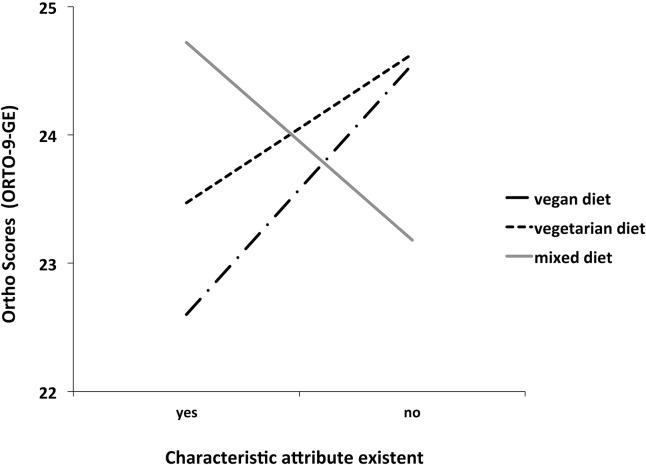
ORTO-9-GE scores associated with dieting style.ORTO-9-GE scores as a function of dieting style. Participants dieting style defined as either vegan, vegetarian or having a mixed diet. Lower ORTO-9-GE scores indicate higher orthorectic tendencies.